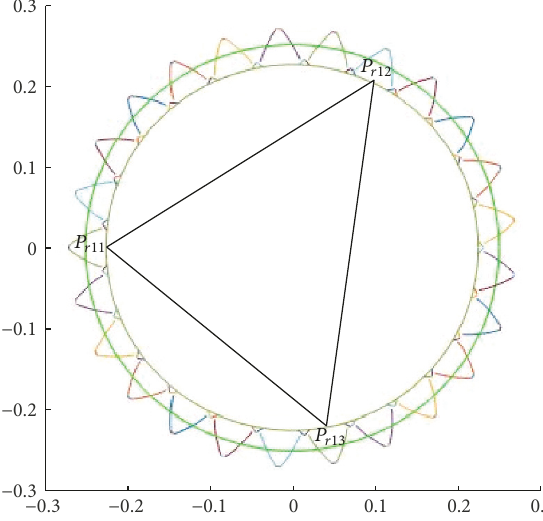
Figure 11: Neighbourhood for obtaining the global best